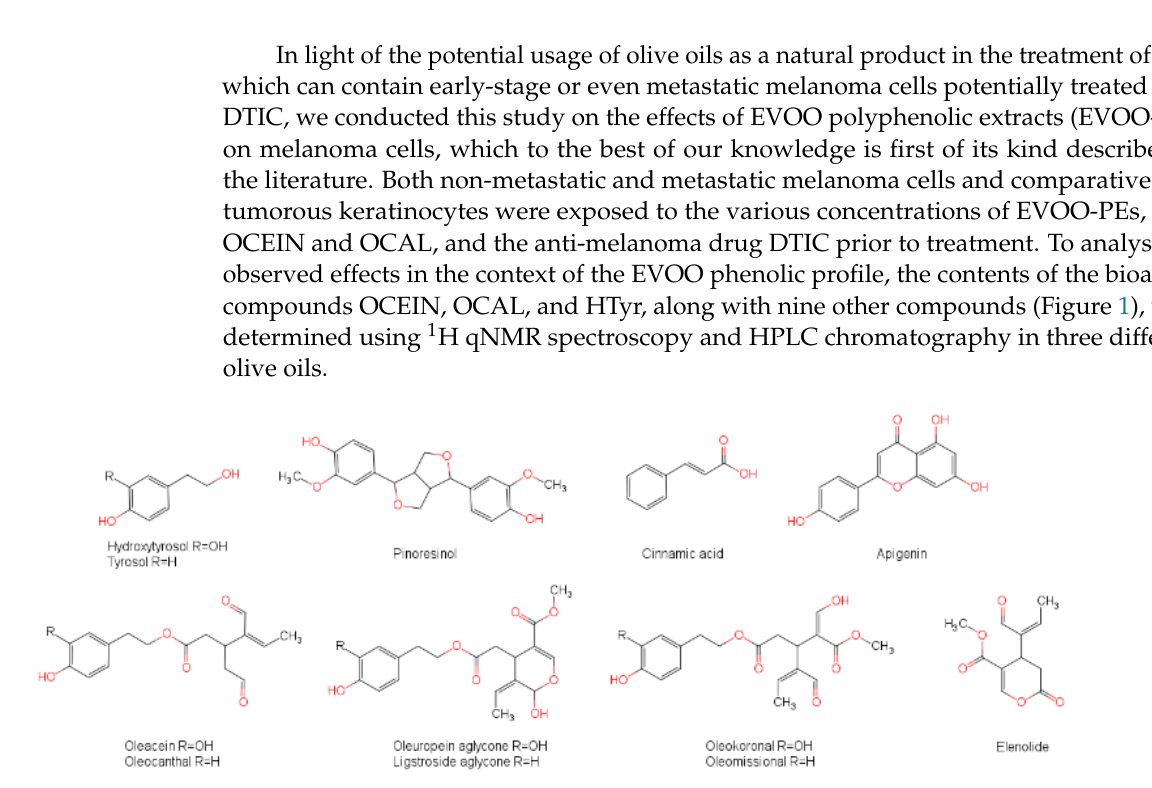
Figure 1. Structures of phenolic compounds/secoiridoids in studied EVOOs.